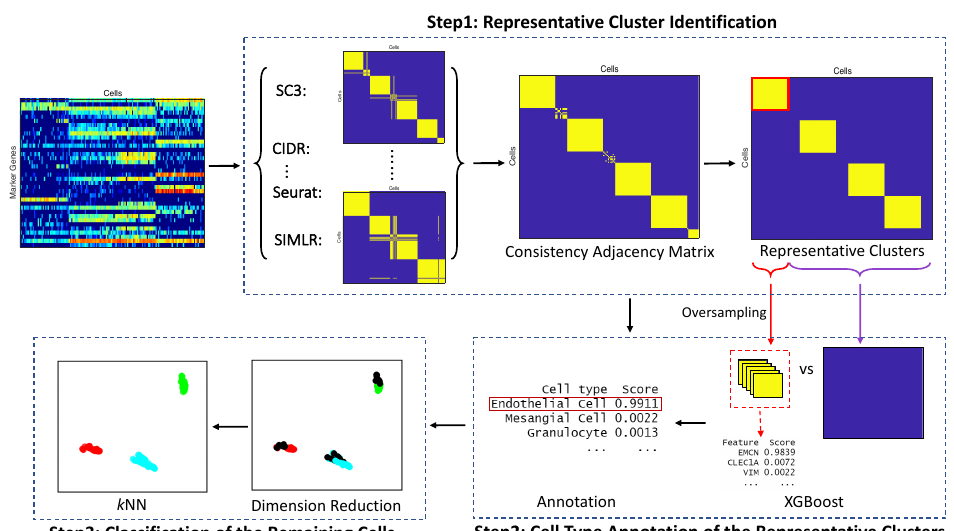
Figure 1. The workflow of ACAM. The input is a log-normalized expression matrix for marker genes only. Markers are selected from the database CellMatch. Step 1. Apply different clustering methods, such as SC3 [27], CIDR [28], t-SNE + k -means [29], and SIMLR [30] to conduct clustering independently, and define the consistency adjacency matrix. Louvain algorithm is applied to identify the representative clusters. Step 2. Apply XGBoost to each representative cluster versus all the remaining cells to obtain each feature’s importance score. Clusters are annotated by the maximum cell type score, which is defined as the sum of the importance score for all the features in each cell type. Step 3. Classify the remaining cells using k -nearest neighbors ( k NN) after dimension